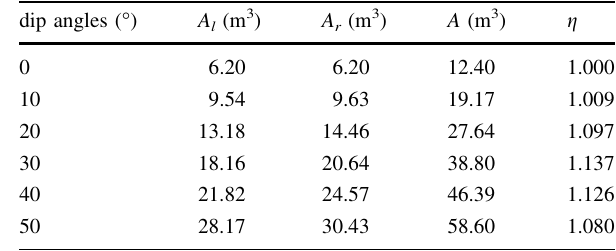
Table 3 Calculated drawing body volumes for different seam dip angles and volume symmetry coefficient in the initial drawing stage